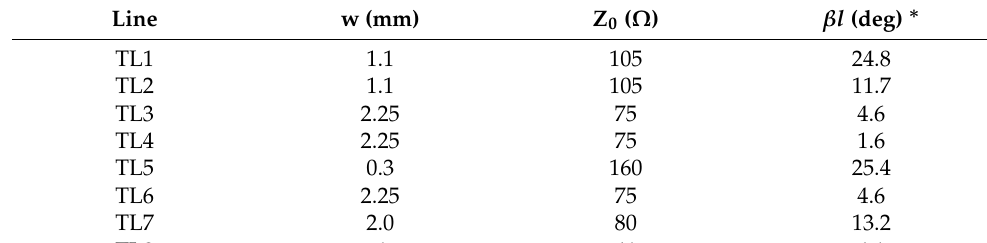
Table 2. Final values of transmission lines of the filter from Figures 9 and 12.